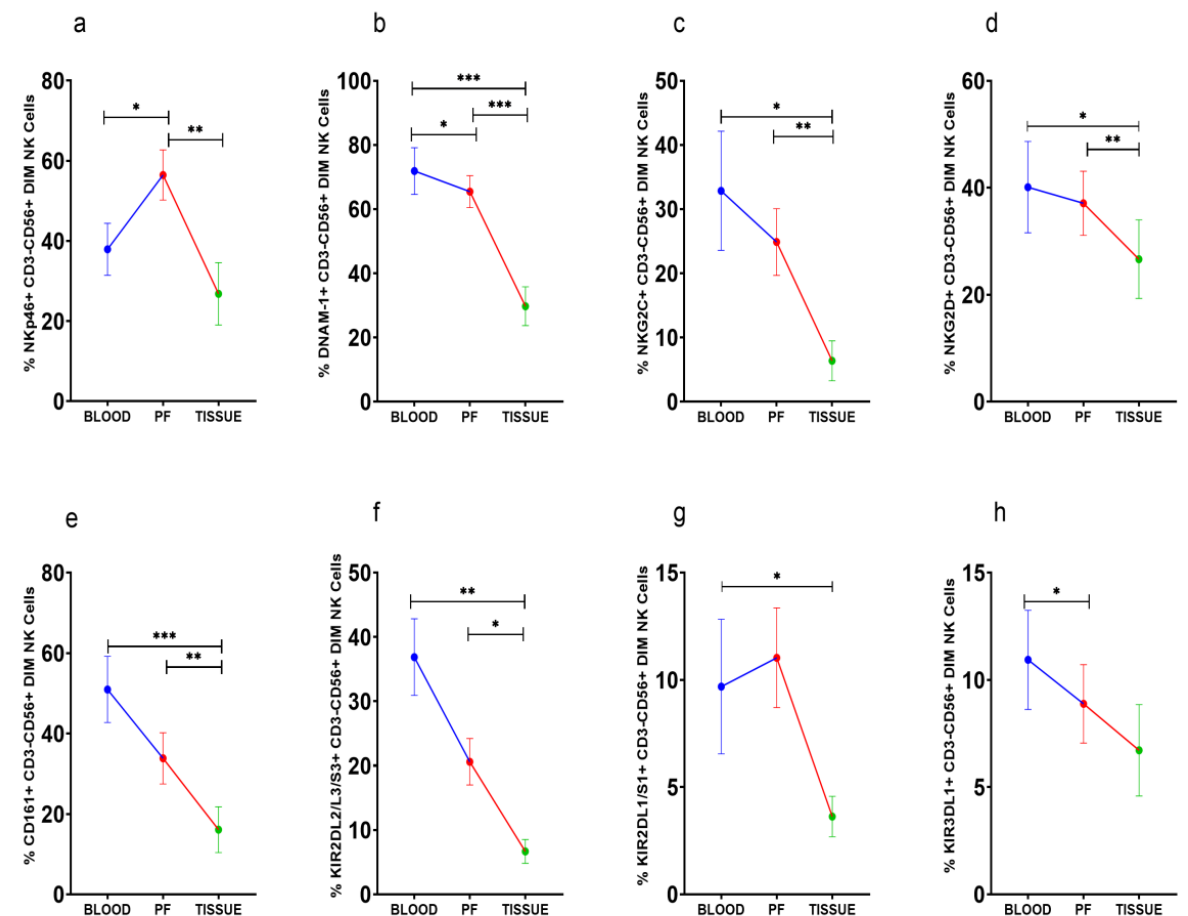
Figure 3. Wilcoxon matched-pairs signed ranked test ( a – h ) for receptor expression profile of CD56 Dim NK cells in peripheral blood, peritoneal fluid (PF), and tissue specimens * p < 0.05; ** p < 0.01; *** p < 0.001.